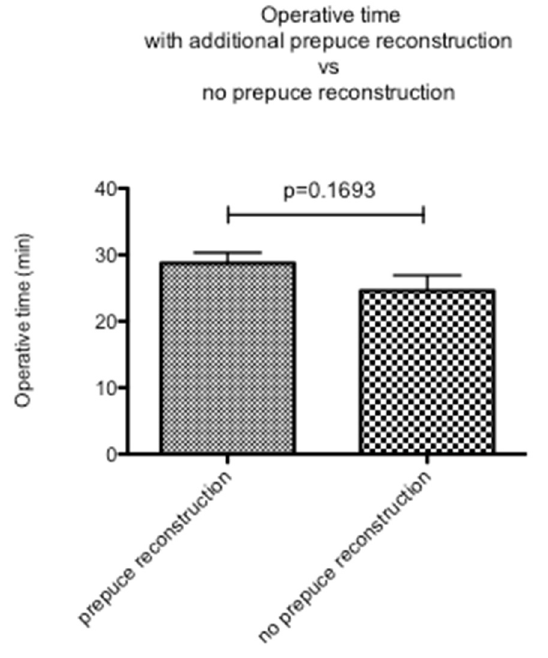
Figure 4. Operative time in patients with additional prepuce reconstruction compared to patients in whom no prepuce was reconstructed.